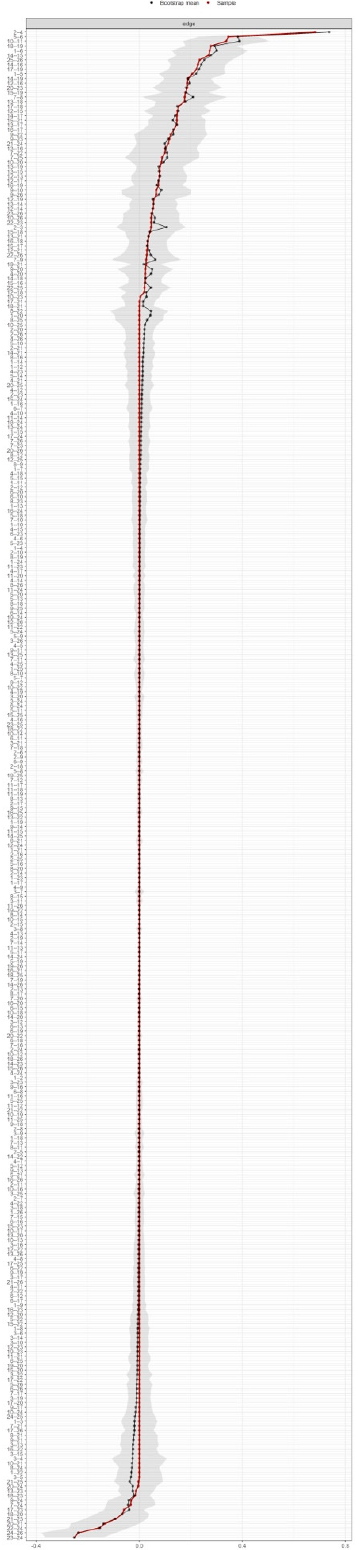
Figure 3. Bootstrapped 95% quantile confidence interval of the estimated edge weights of the network. “Bootstrap mean” reflects the average magnitude of edge weights across the bootstrapped samples. “Sample” reflects the magnitude of edge weights of the original network built on the entire input dataset.